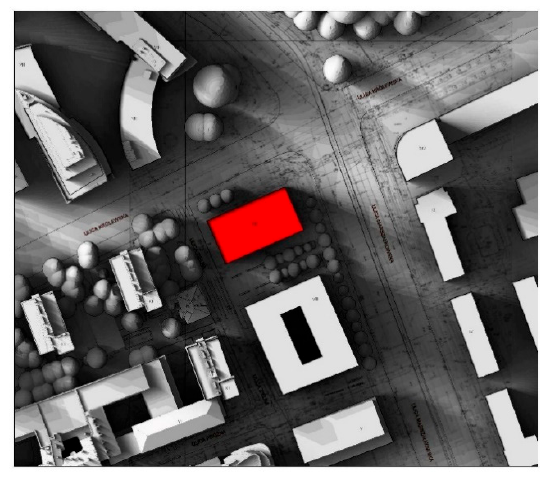
Figure 4. Spring Equinox. Collective shadow analysis for designed building.